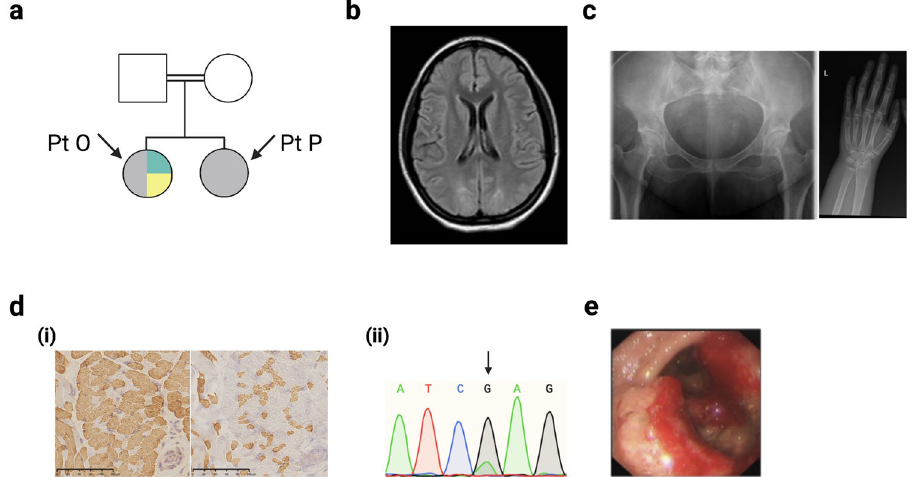
radiographdemonstrateselongatedfemoralnecks,leftradiographshowslongand tapered fi ngers) and review of the history revealed recurrent joint